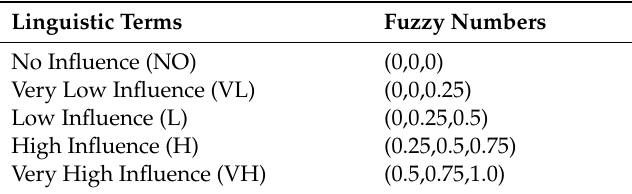
Table 4. Linguistic variables for criteria